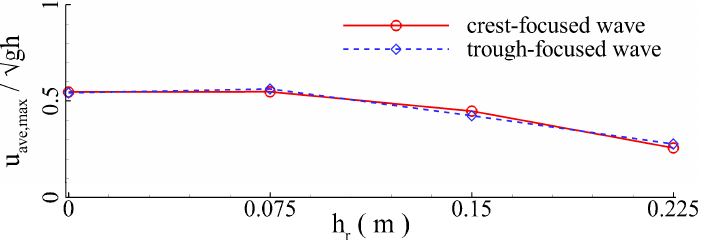
Figure 38. Local maximum depth-averaged velocity at the reef crest versus the submergence water depth.